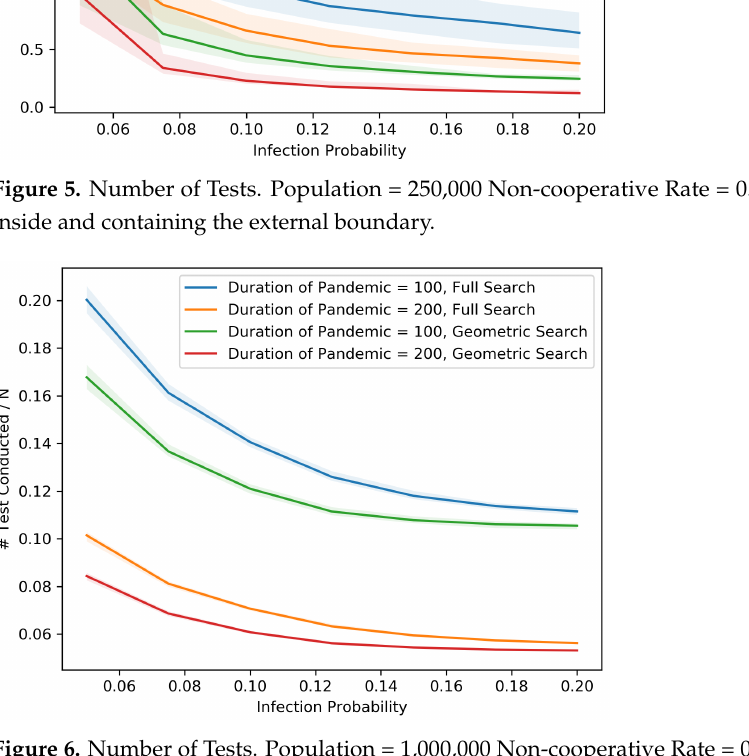
Figure 6. Number of Tests. Population = 1,000,000 Non-cooperative Rate = 0. N: number of people inside and containing the external boundary.